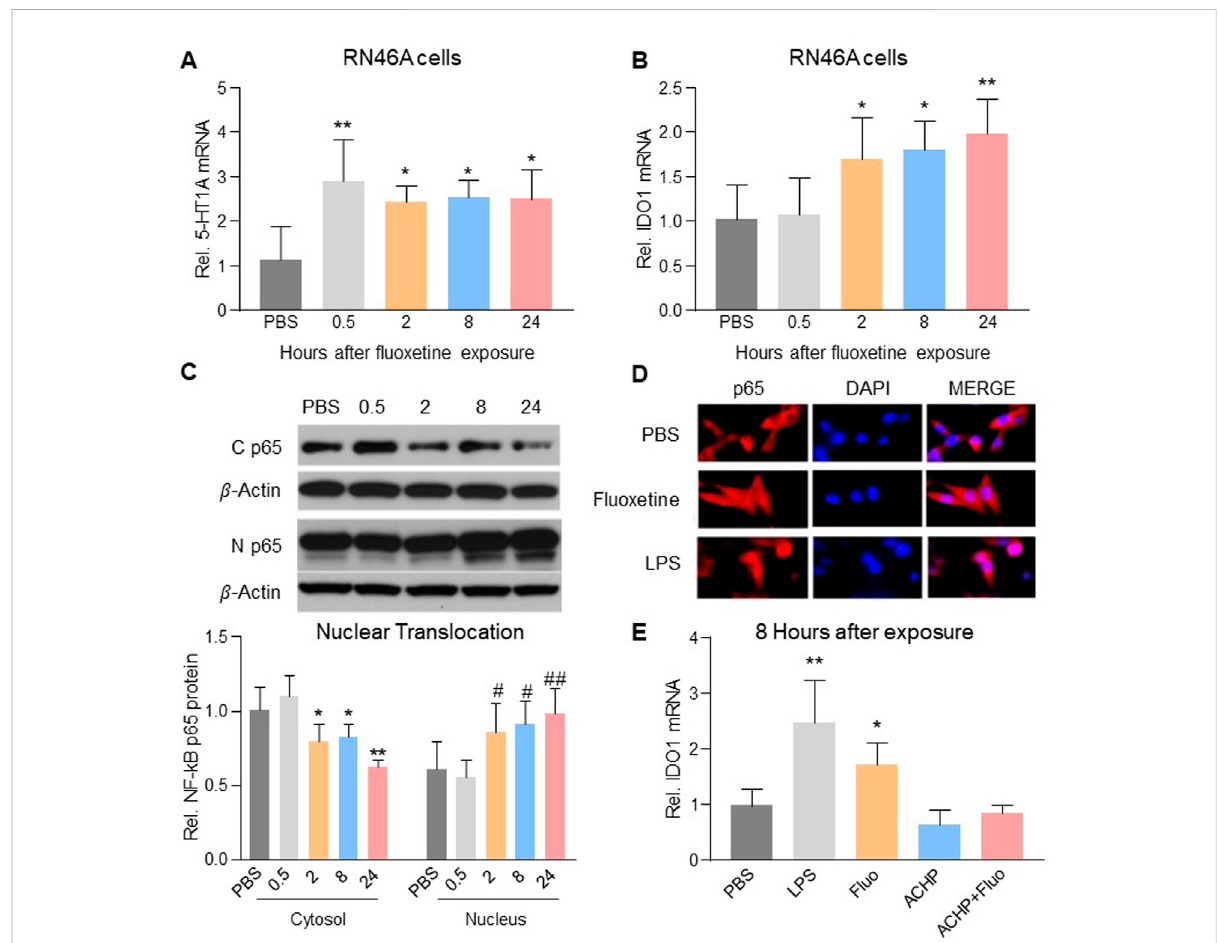
FIGURE 3 Fluoxetine mediated the upregulation of IDO1 expression via NF- k B-IDO1 pathway. Fluoxetine upregulated mRNA expression of 5-HT1A receptors (A) from 0.5 h and IDO1 (B) from 2 h after exposure. (C) From 2 h after fl uoxetine exposure, the level of NF- k B p65 protein in cytosol decreased, but its level in the nucleus increased. (D) NF- k B p65 immunoreactivity detected in the nucleus (merged with DAPI) was higher in fl uoxetine and LPS exposure RN46A cells than in PBS control cells. (E) LPS and fl uoxetine exposure both signi fi cantly increased the mRNA expression of IDO1, which was reversed in ACHP alone and ACHP combined with fl uoxetine exposure groups. The data are presented as mean ± SD ( n = 6). * p < 0.05 and ** p < 0.01 compared to the PBS treated group, # p < 0.05 and ## p < 0.01 compared to the PBS treated group (Nucleus). Rel. Indicates relative; C p65, Cytosol NF- k B p65; N p65, Nucleus NF- k B p65; Veh, vehicle; Fluo, fl